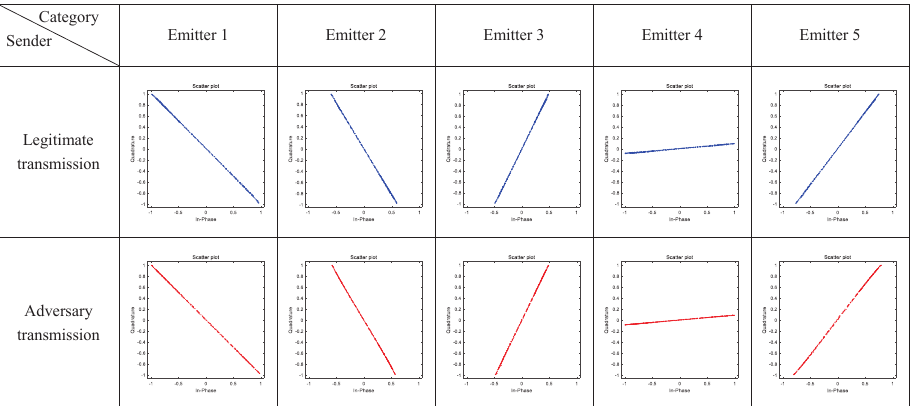
Figure 6. The constellation diagrams of legitimate and spoofing BPSK signals with different legitimate emitters.